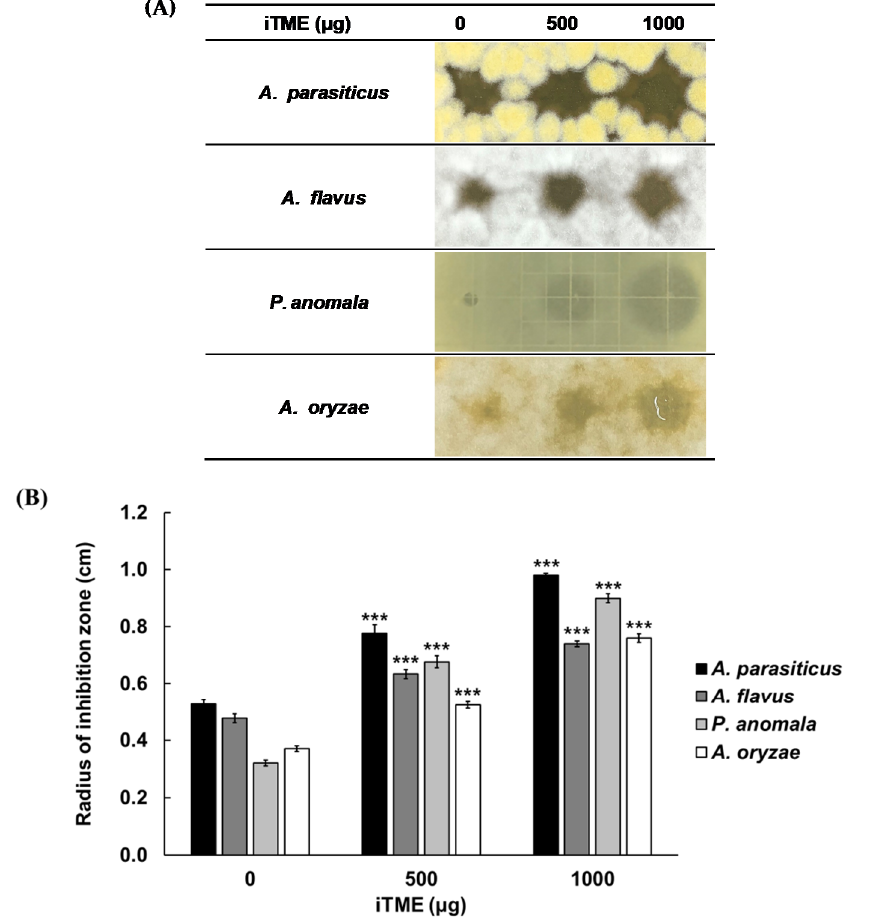
Figure 3. Evaluation of the antifungal activities of iTME against harmful fungi ( Aspergillus parasiticus , A. flavus , Pichia anomala ), and beneficial fungi ( A. oryzae ) using RDA ( A ) and by measuring the radius of inhibition zone ( B ). Values are reported as mean ± standard deviation of triplicate experiments. *** p < 0.001 represent significant differences between 0 µg and 500, 1000 µg, respectively.